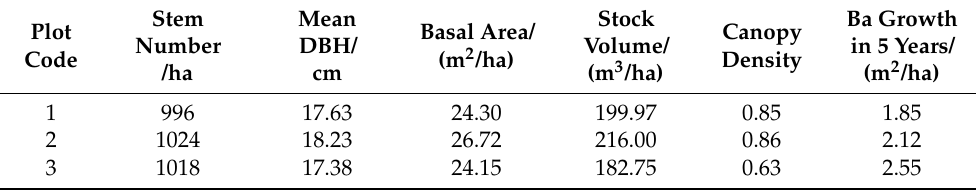
Figure 1. Location of study area: Wangqing Forest Bureau in northeast China and spatial distribution of 3 sample plots (bottom). Table 1. Stand characteristic of 3 plots.